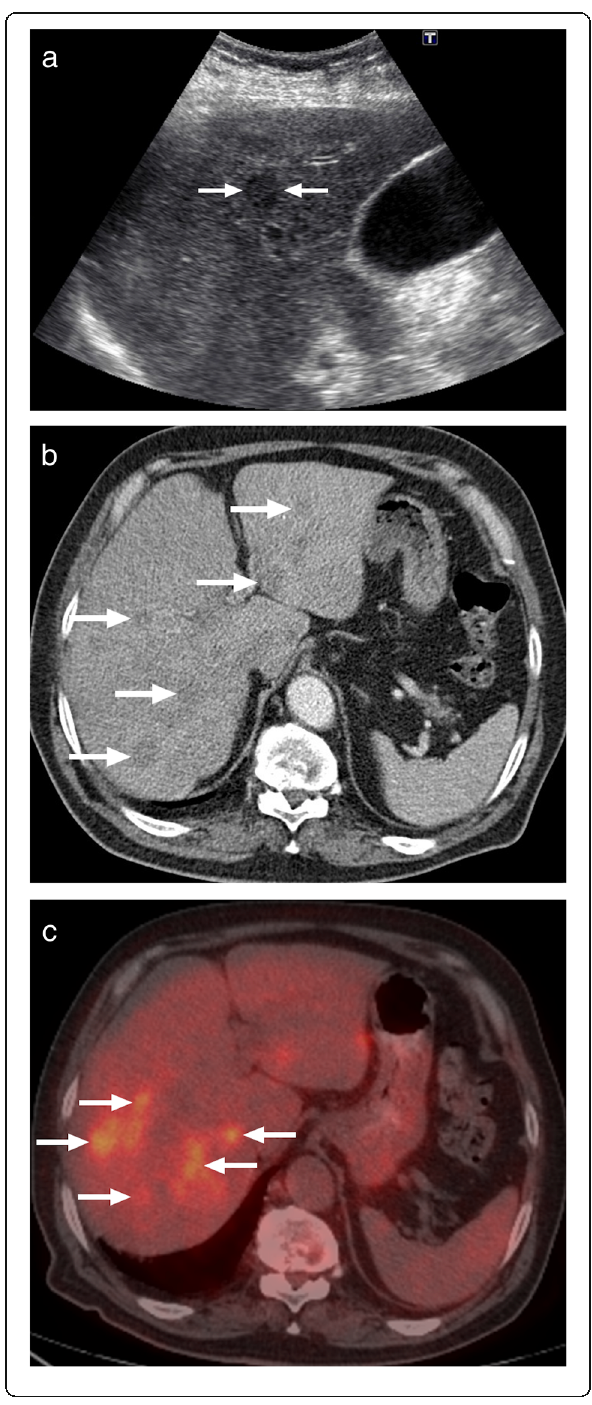
Fig. 18 A 60-year-old male with previously treated lymphoma, in complete clinical and imaging remission, now presents with fatigue, fever, and malaise. a Abdominal US image demonstrated several hardly discernible subcentimeter lesions throughout the liver parenchyma. Only one lesion was larger than a centimeter (arrows). b Axial plane postcontrast CT image demonstrates innumerable hypodense lesions (arrows). c On PET-CT, these lesions were found to be metabolically active with intense FDG uptake (arrows). Chest and neck CT studies were unremarkable (not shown). Percutaneous biopsy surprisingly showed noncaseating granulomas consistent with sarcoidosis. Symptoms and imaging findings promptly